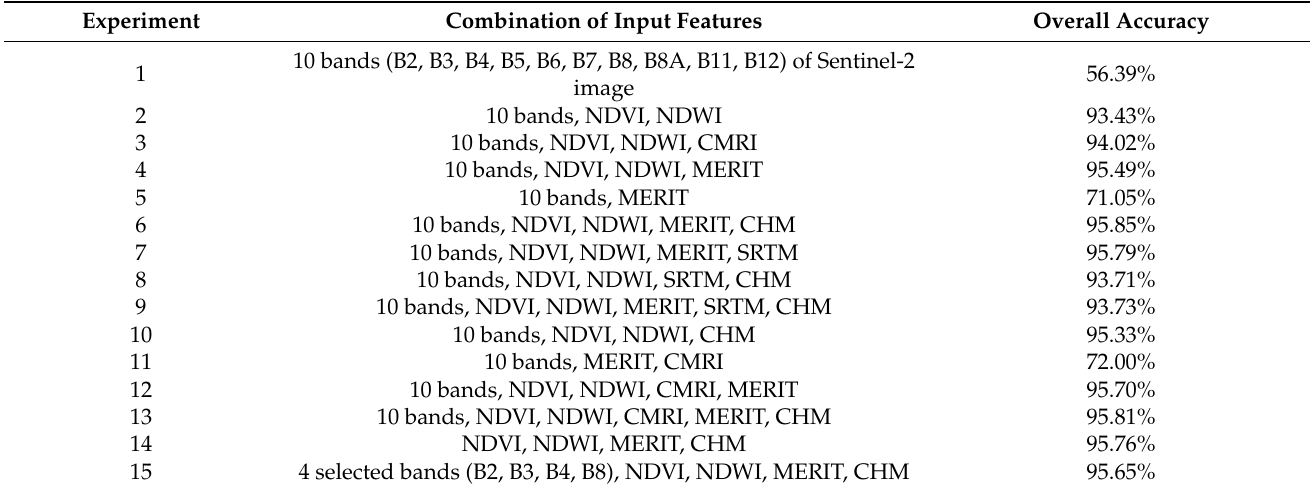
Table 3. Experimental results of input feature